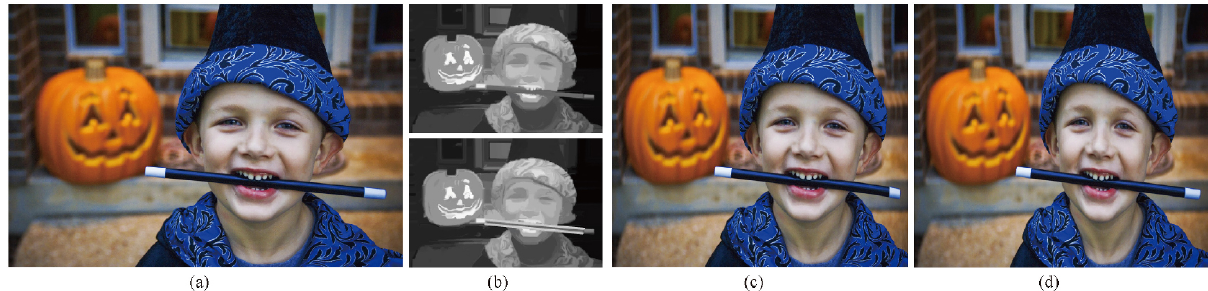
Fig. 12 Resizing results to 75% of the original width while preserving straight line structures. (a) Input image. (b) Original saliency map (top) and saliency map with line structures highlighted (bottom). (c) Warping results based on original saliency map. (d) Warping results based on saliency map with line